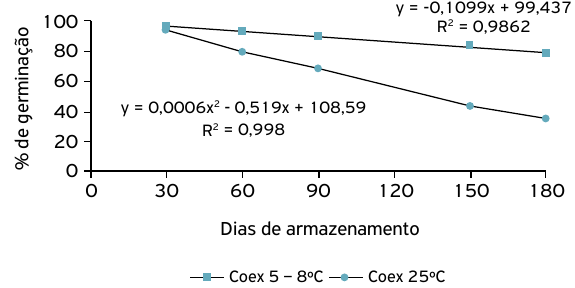
Figura 1. Porcentagem de germinação de conídios de B. bassiana em mistura granulada acondicionada em embalagem tipo Coex.